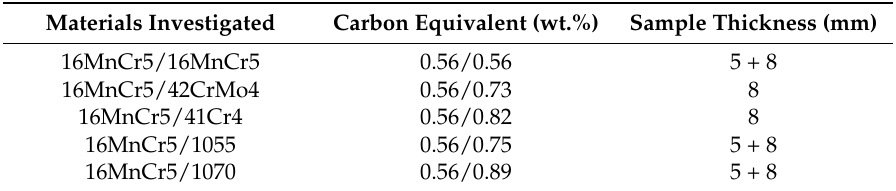
Table 2. The different material combinations and thicknesses that were laser welded together with the corresponding carbon